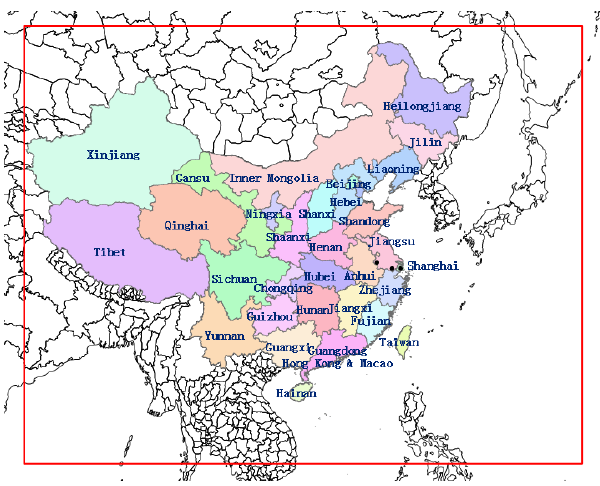
Figure 2. The modeling domain. The black points represent the lo- cations of the nitrate